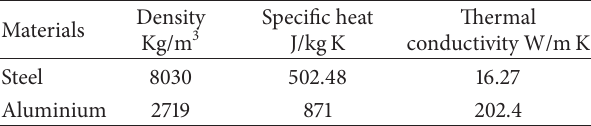
Table 2: Thermophysical properties of the materials.